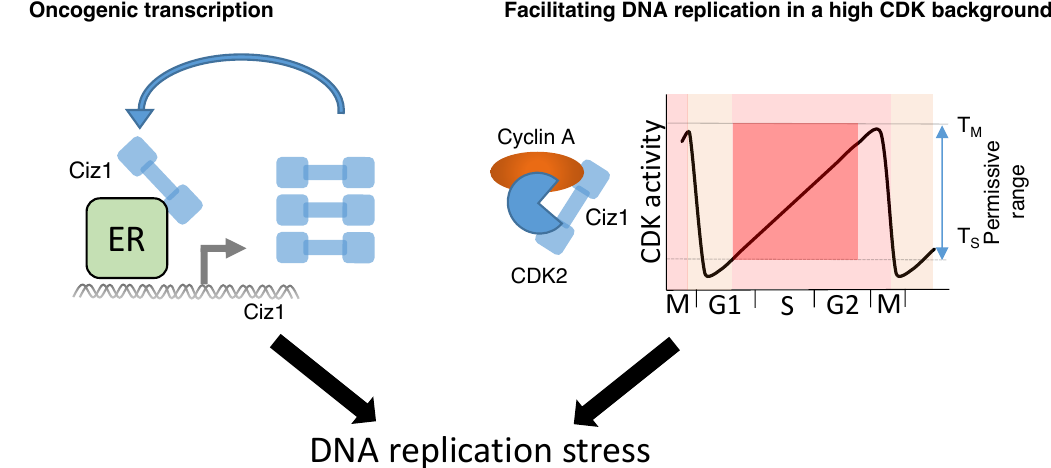
Figure 3. Ciz1 may contribute to DNA replication stress via stimulation of oncogenic transcription and deregulation of the cell cycle. ( A ) Oncogenic transcriptional activation mediated by Ciz1 is shown. In this example, estrogen receptor (ER) is sensitized by Ciz1 interactions leading to a positive feedback mechanism, increasing Ciz1 transcript levels. Ciz1 also increases oncogenic transcription with Yes associated protein 1/ Tafazzin (YAP/TAZ) and Beta catenin/Wnt (Int/Wingless) signaling [77,79,80]; ( B ) Ciz1 can greatly enhance the permissive concentration of cyclin A-CDK2 that can facilitate initiation of DNA replication. In this model, deregulation of cyclin expression associated with